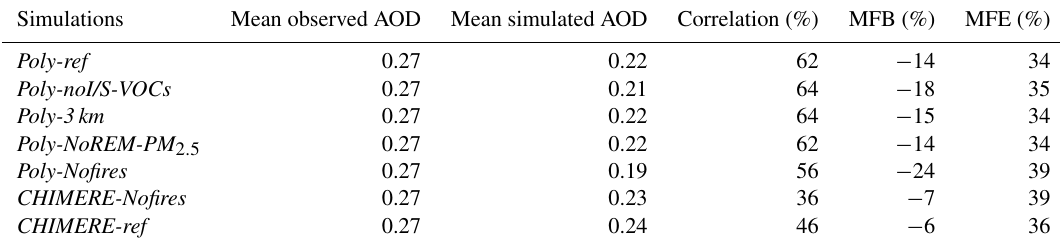
Table 4. Statistics of models-to-measurements comparisons for mean daily AOD at 550nm during the summer of 2007 (AERONET station number =